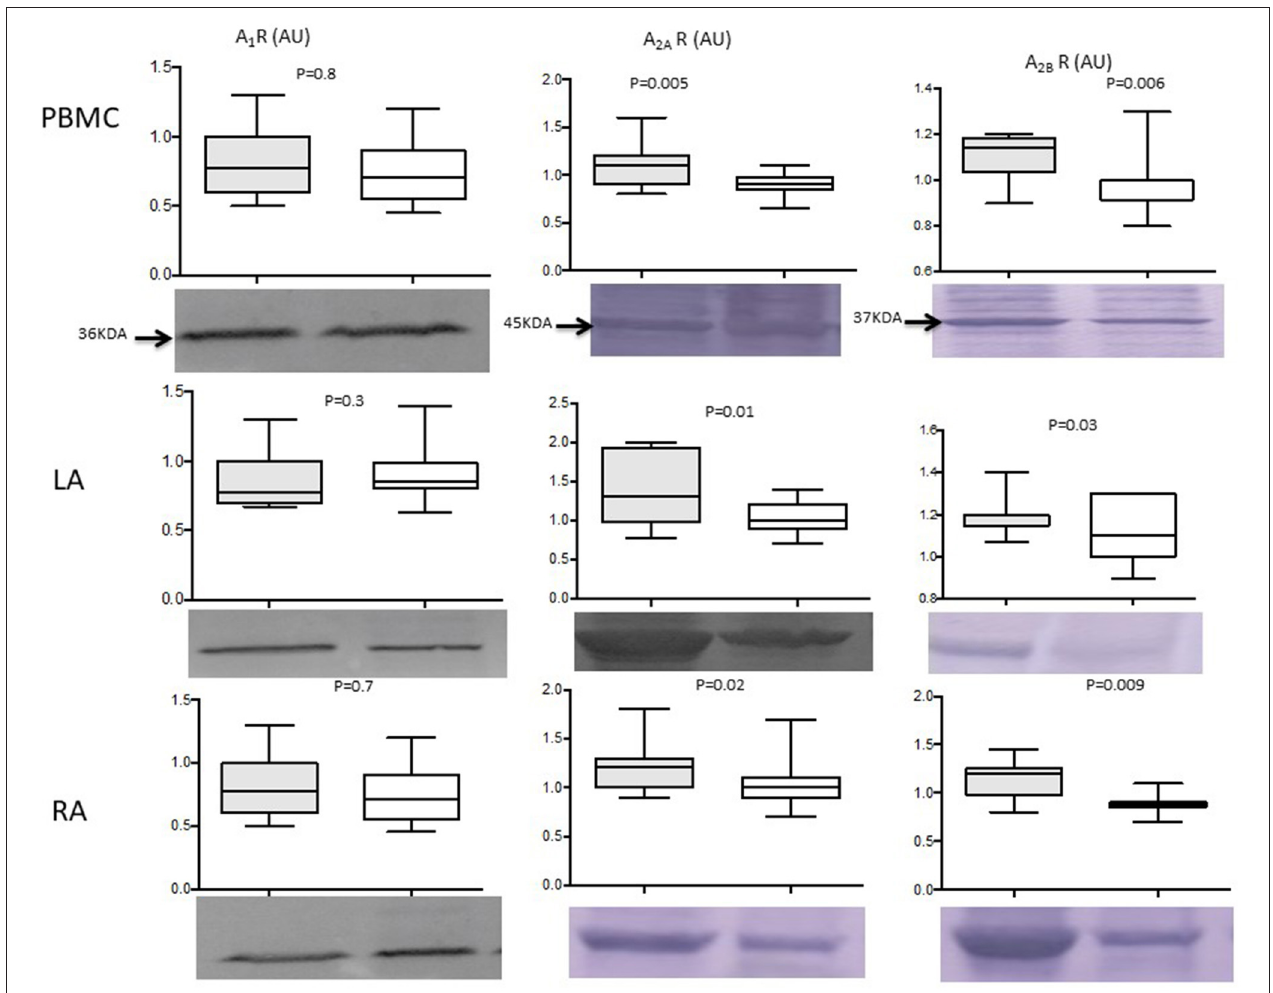
FIGURE 3 | Central picture: Adenosine receptor production evaluated by western blotting, in 39 patients undergoing cardiac surgery [15 with perioperative atrial fibrillation (PeOpAF) in the gray box]. White box represents patients without perioperative atrial fibrillation. PBMCs, peripheral blood mononuclear cells; LA, left atria; RA, right atria; KDA, molecular weight in kilodaltons. A 1 R, A 2A R, and A 2B R are A 1 , A 2A , and A 2B adenosine receptors respectively. Box indicates mean ± SD and vertical lines indicate the range. Adenosine receptor production in PeOpAF patients (gray box) vs. no PeOpAF (white box).